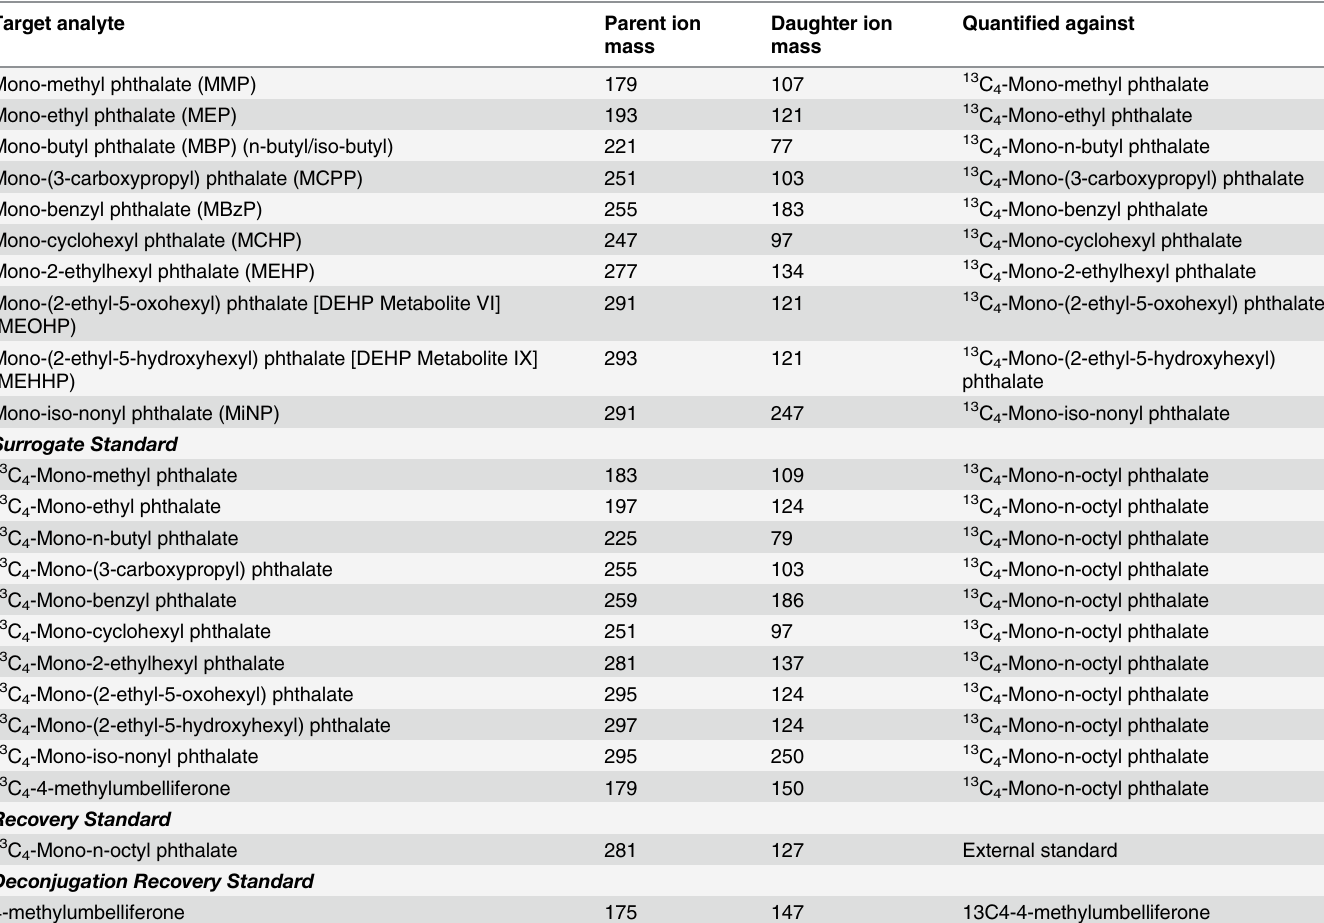
Table 1. Analytes, ions, and quantification